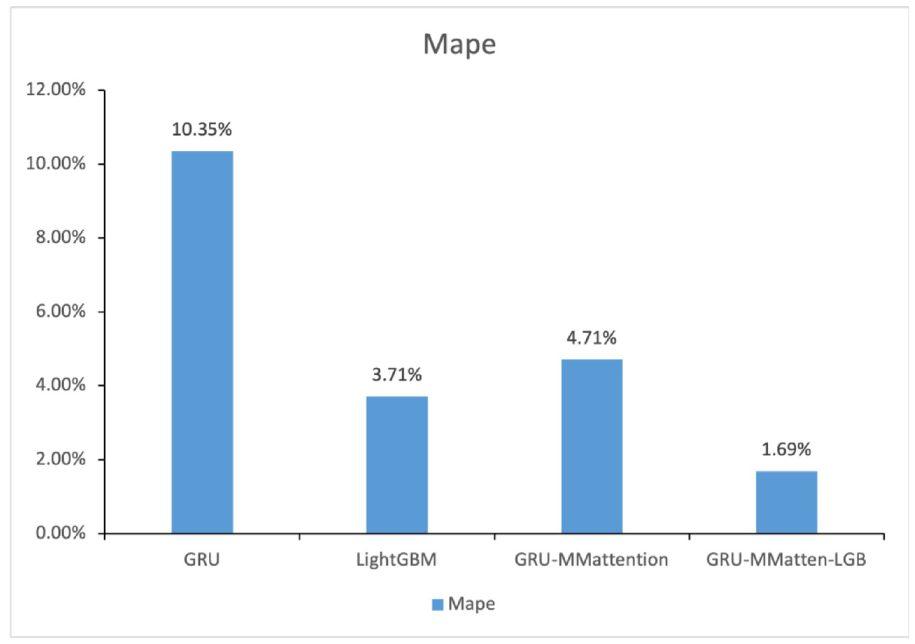
Fig 10. Comparison of all model